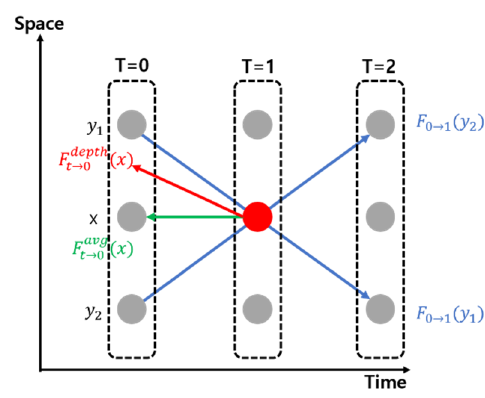
Figure 5. DAIN flow projection.